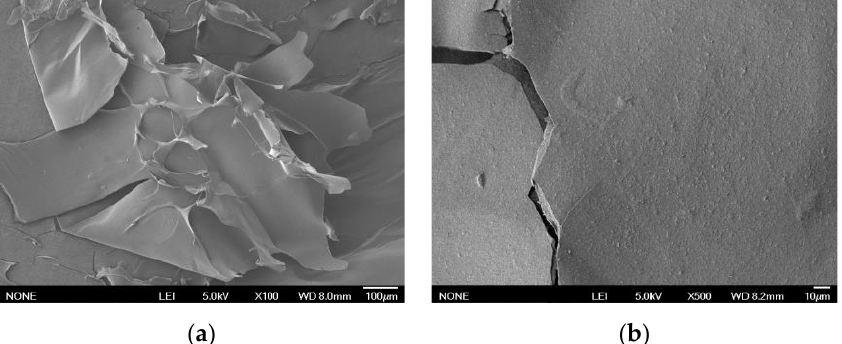
Figure 2. Scanning electron micrographs of GP-IDF-SDF collected at 100× ( a ) and 500× ( b ) magnifi- cations.